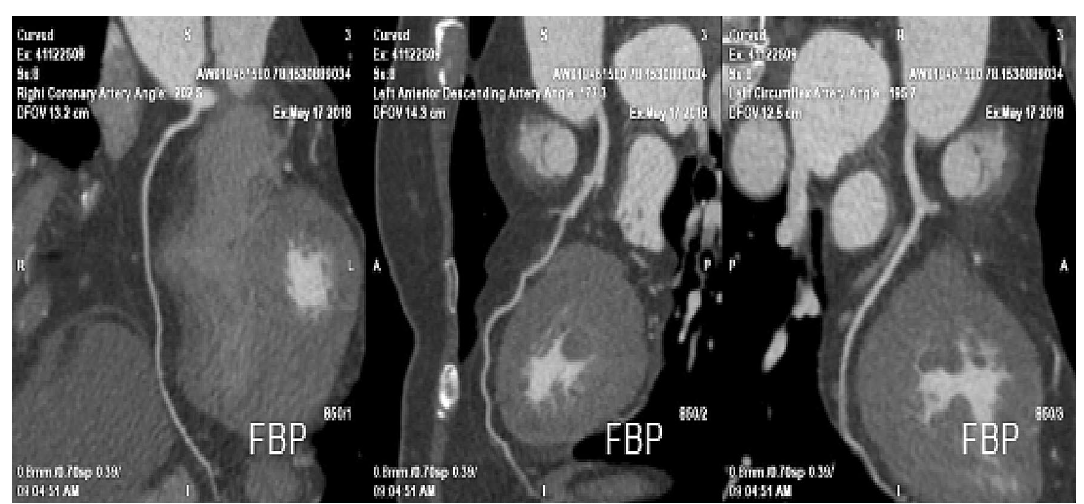
Figure 3. Representative image of a 59-year-old female patient, body surface area (BSA) 1.48 m 2 , body mass index (BMI) 23.8 kg/m 2 , heart rate (HR) 85 bpm, using 40 mL of contrast agent injected at a flow rate of 3.5 mL/s on a Force computed tomography